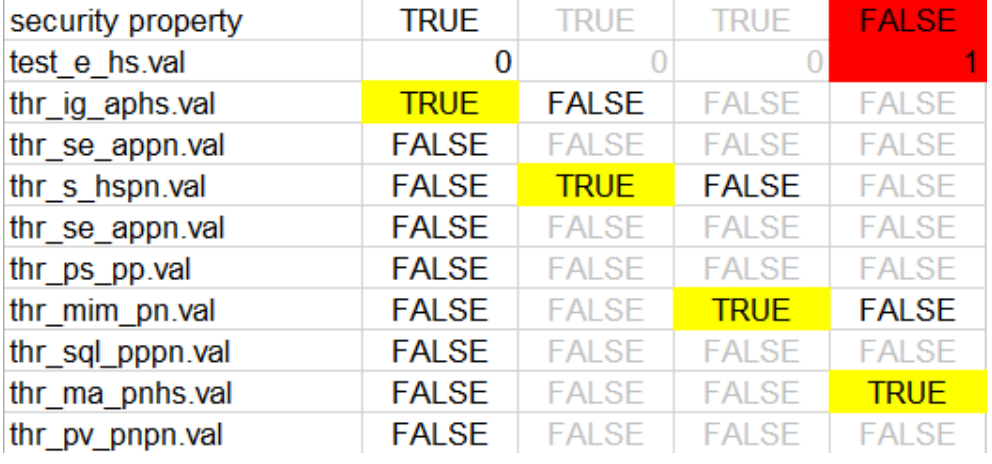
Figure 3. CE1 spreadsheet. Figure 3. CE1